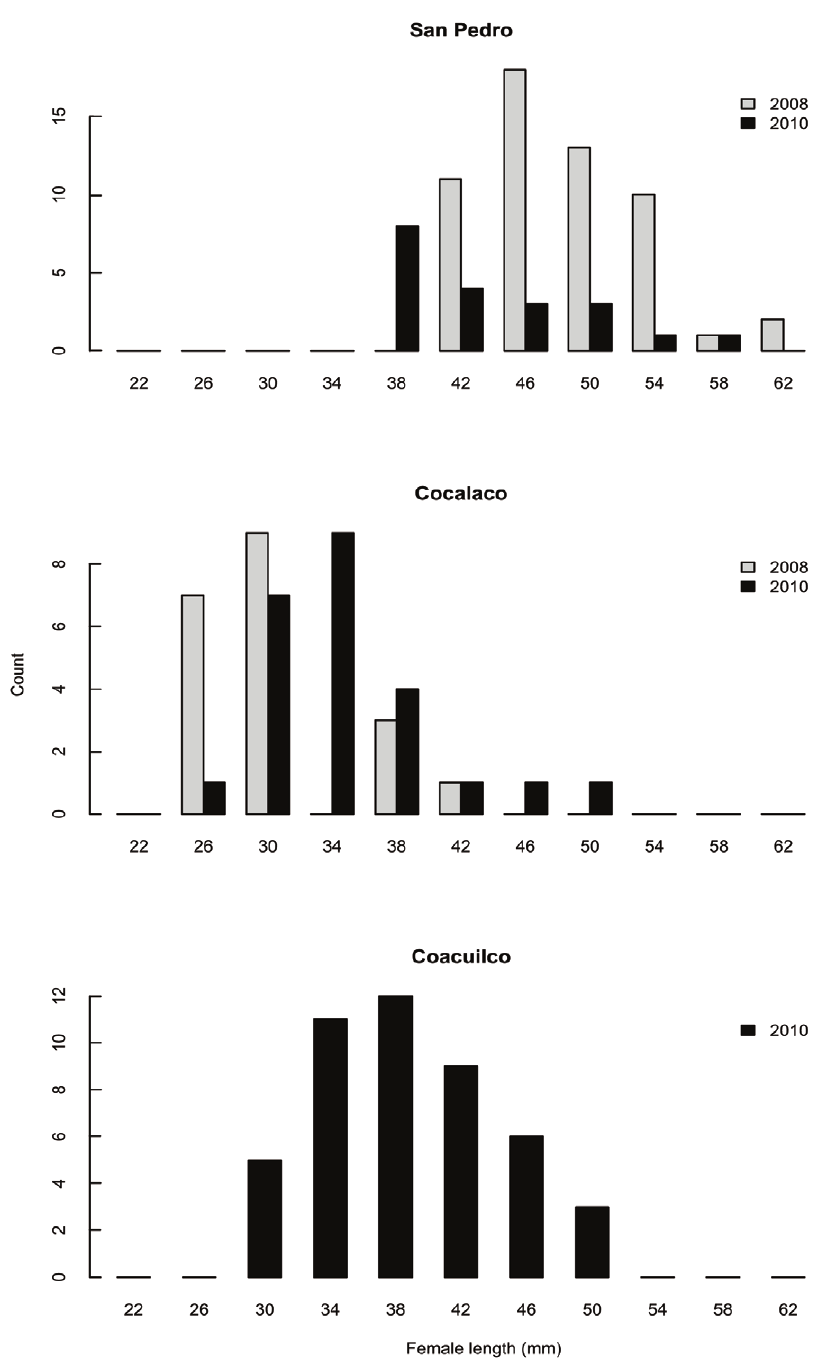
Figure 1. Site and year differences in female sizes (standard length, in mm). Females are mature (i.e., gravid). Top panel: San Pedro. Middle panel: Cocalaco. Bottom panel: Coacuilco. In 2010 we added Coacuilco as a third site to examine females in a size range intermediate to San Pedro and Cocalaco. doi:10.1371/journal.pone.0048473.g001 terms from the final model (ANCOVA: F 2, 88 = 53.9; P , 0.001). Female size, age, site, and all interactions were significant predictors of female condition (ANCOVA: F 7, 50 =7.1; P , 0.001). This initial analysis suggests that the largest females tended to be the oldest and in the best condition across sites (Figure S1). The differences in adult female size and age among sites reflected differences in size and age at maturity of females in